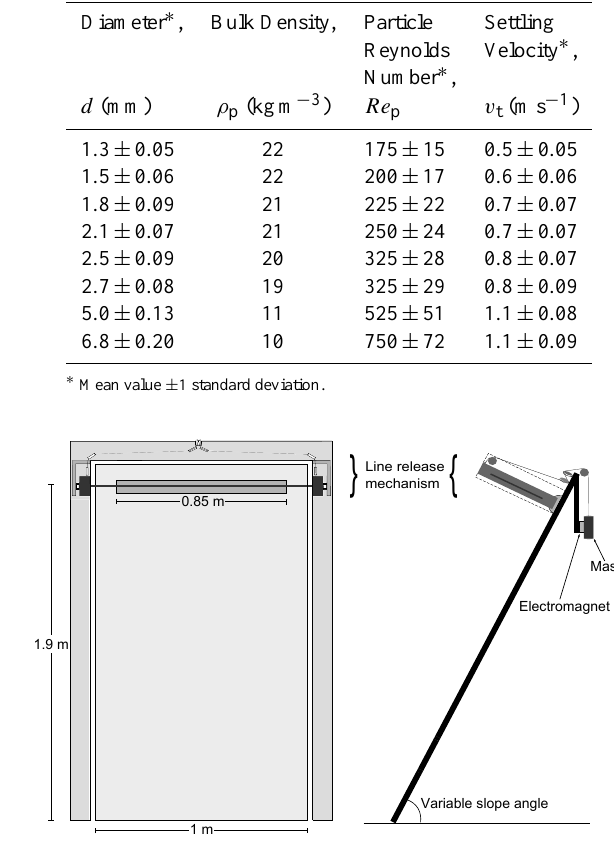
Fig. 1. Front and side view schematic of the chute used for experi-